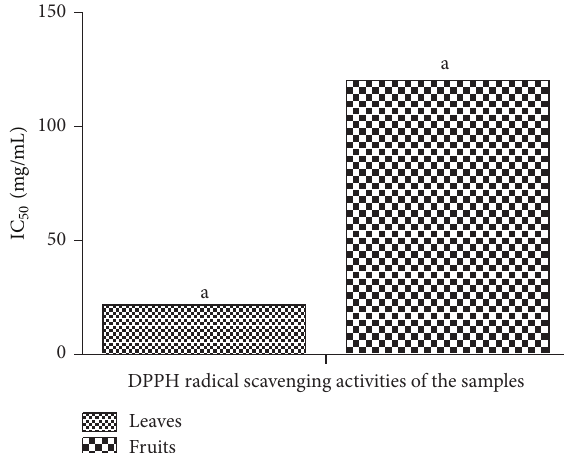
Figure 4: DPPH radical scavenging activity in the aqueous extracts of the leaves and fruits of Nauclea latifolia. All significant differences are at 𝑃 < 0.05 . a-a Bars having the same alphabets are significantly different from each